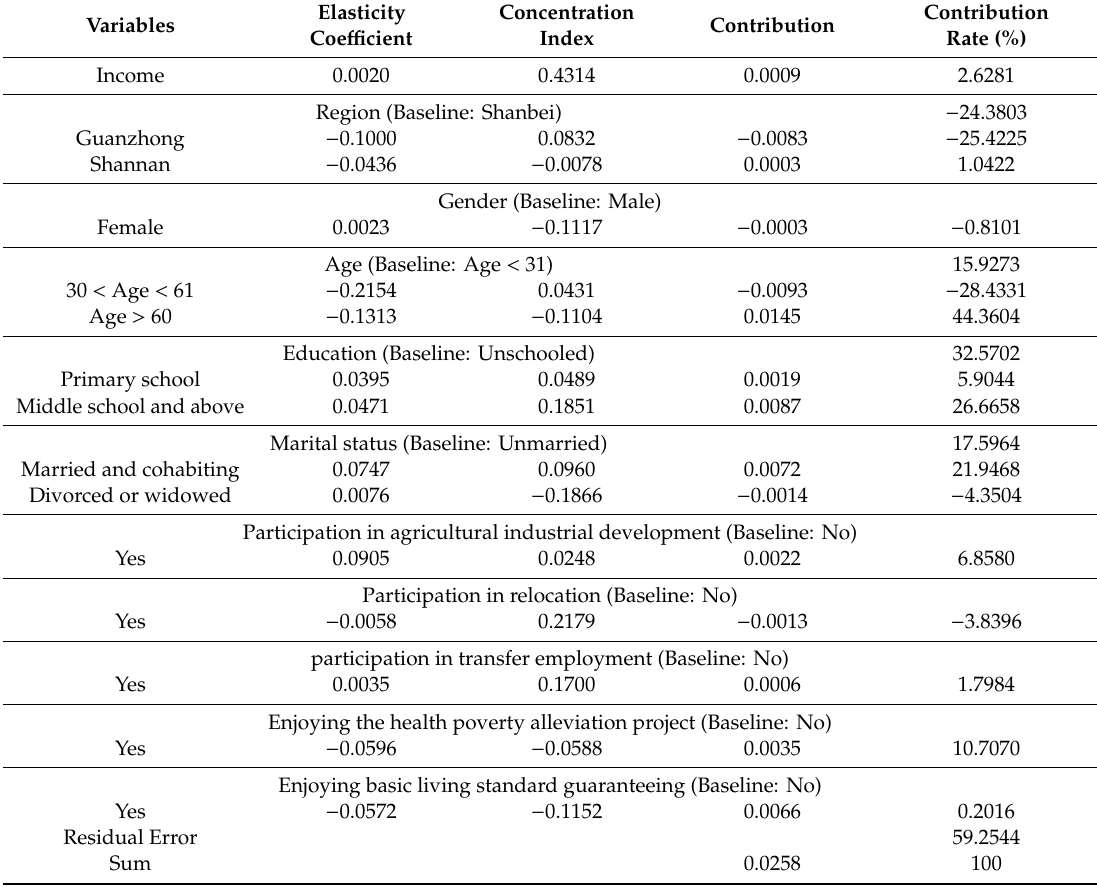
Table 5. Decomposition of health inequity of the rural poor residents in Shannxi